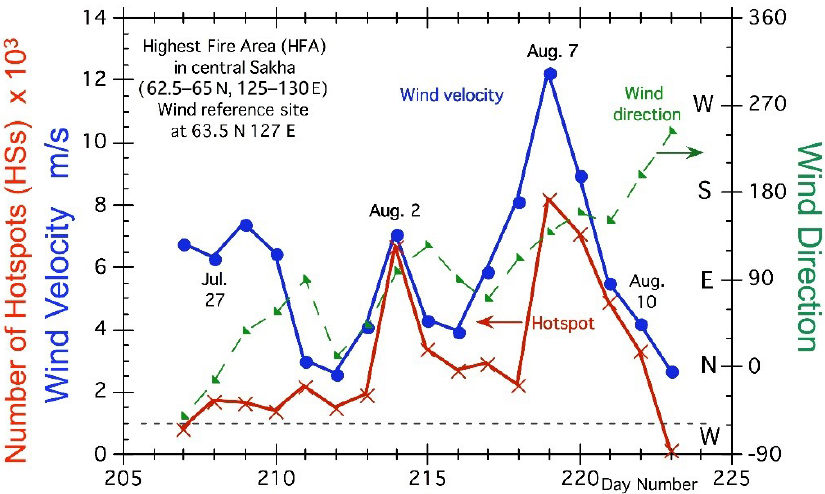
Figure 8. Wind conditions and fire (HS) activity in HFA during the active fire period in